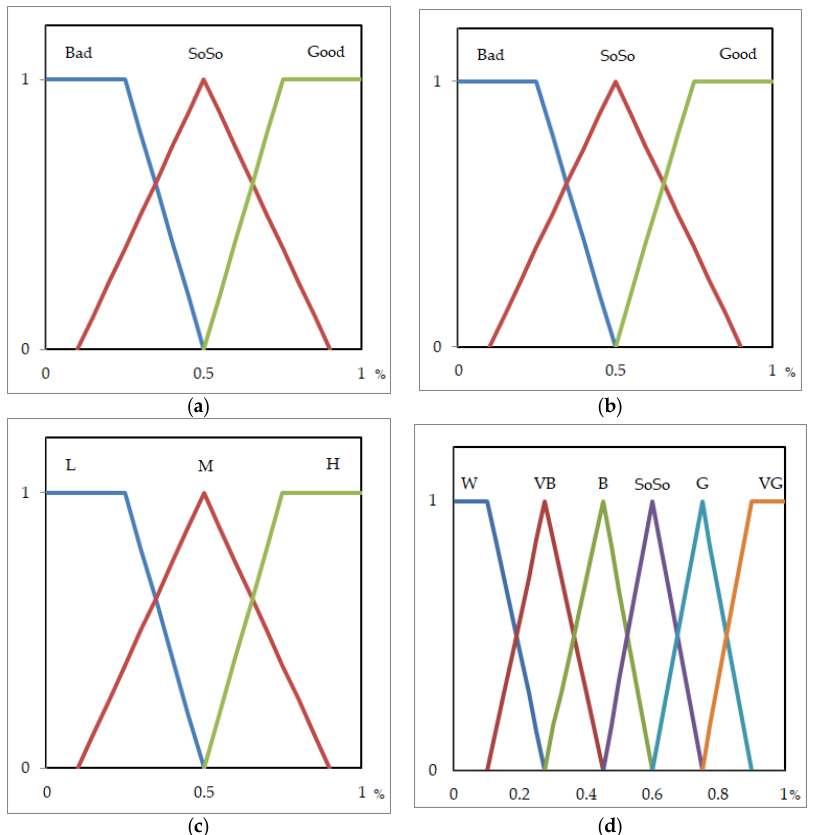
Figure 10. Brunnstrom Level MFs ( a ) FMR ( b )PMR ( c ) LTCMR, and ( d ) Brunnstrom Level.